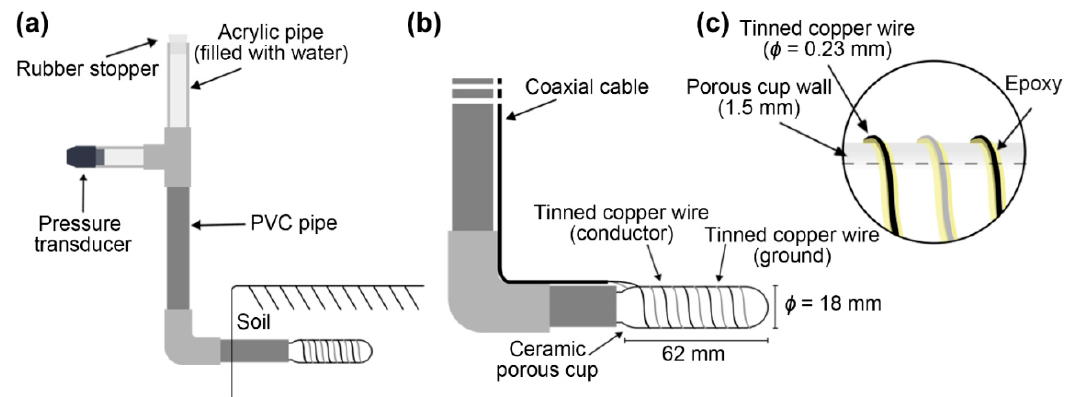
Figure 1. Design of the tensiometer-time domain reflectometry (T-TDR) probe showing ( a ) the side view inserted into the undisturbed soil profile, ( b ) the TDR portion of the probe, and ( c ) the portion of parallel tinned copper wires coiled along the porous ceramic